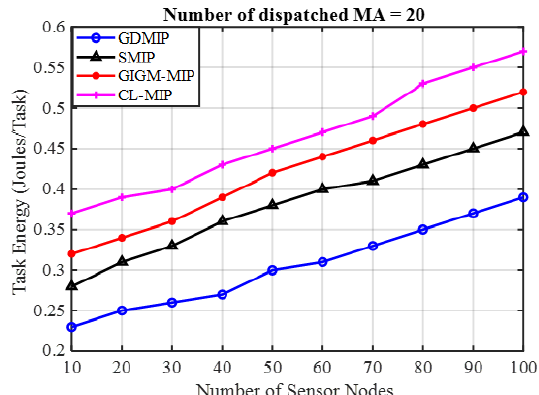
Figure 6. The Impact of Number of Dispatched MAs on Energy Consumption.